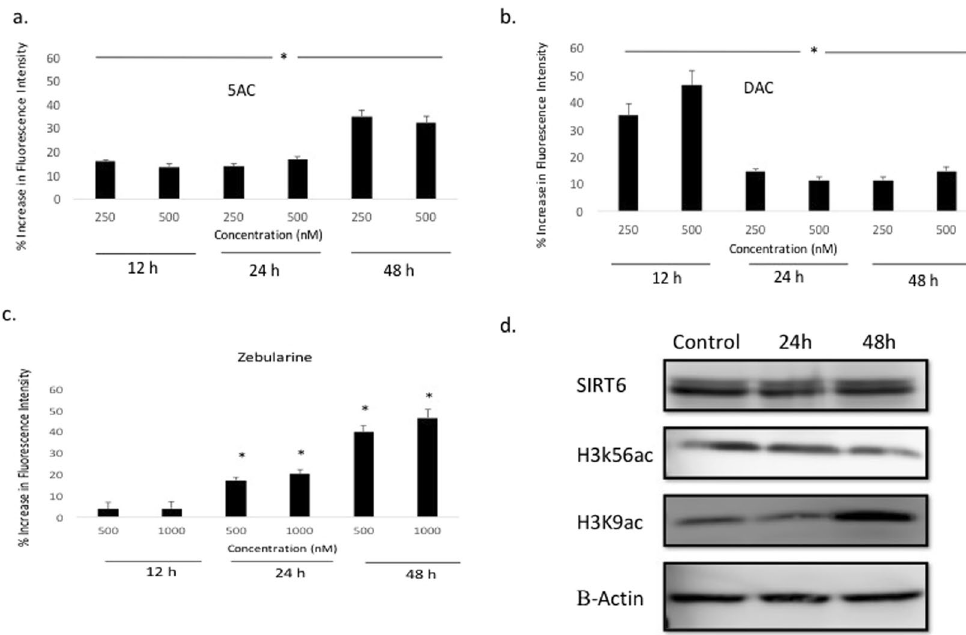
Figure 3. Nucleoside analogs DHAs increase nuclear SIRT6 activity and decrease global expression of acetylated H3K9 and H3K56. U937 leukemia cells were treated with 5AC ( a ), DAC ( b ) and Zebularine ( c ) for 12, 24 and 48 hours followed by nuclear extraction and incubation with a SIRT6 substrate peptide as described under methods. Fluorescence intensity was measured at excitation/emission 480/520 nm and DMSO-treated control was used as a reference to calculate the % increase. Data represent the mean of triplicates ± SD and * indicates significant difference at p < 0.05. ( d ) U937 leukemia cells were treated with 500 nM DAC for 24 and 48 h followed by protein extraction and western blotting for SIRT6, acetylated H3K9 (H3K9ac) and acetylated H3K56 (H3K56ac). Beta-Actin was used as a loading control. The figure represents three different gels full length blots grouped together with dividing lines to indicate that. The full-length blots are included in the supplementary data (Fig.